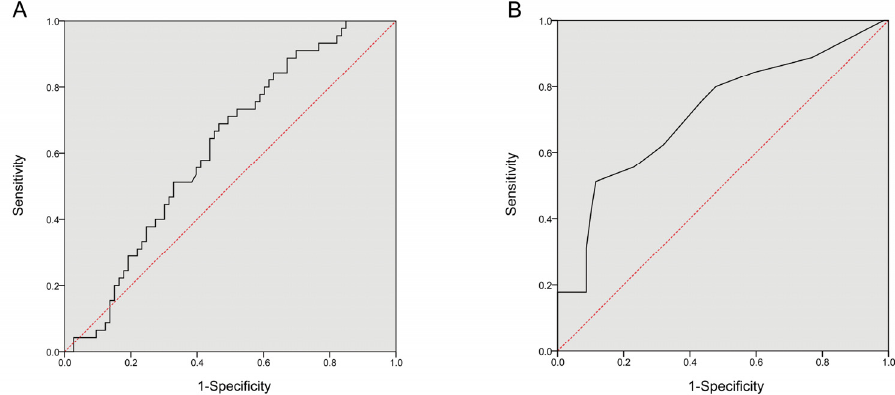
Figure 3. The clinical value of TGF- β 1 and cardiac troponin T (cTnT) . ( A ) : Receiver operating characteristic (ROC) curve about the ability of serum TGF- β 1 levels evaluating preclinical cardiovascular injury in NSCLC patients ( p = 0.035, the Youden’s index = 0.223). ( B ): ROC curve about the clinical value of cTnT for preclinical cardiovascular injuries in NSCLC patients ( p < 0.0001, the Youden’s index =